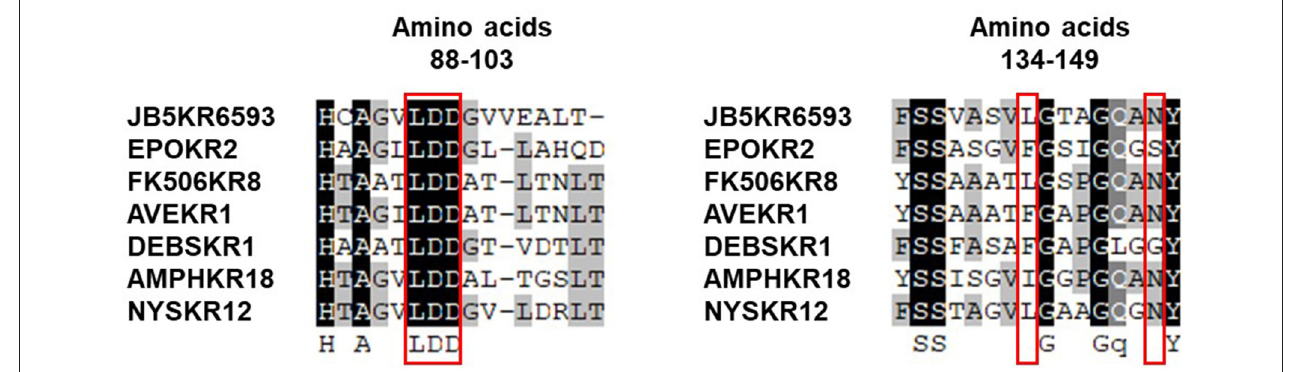
FIGURE 6 | Sequence alignment of KR domains in the biosynthetic gene cluster of dentigerumycin E (JB5KR6593) and various other PKSs reported by Caffrey (2003).